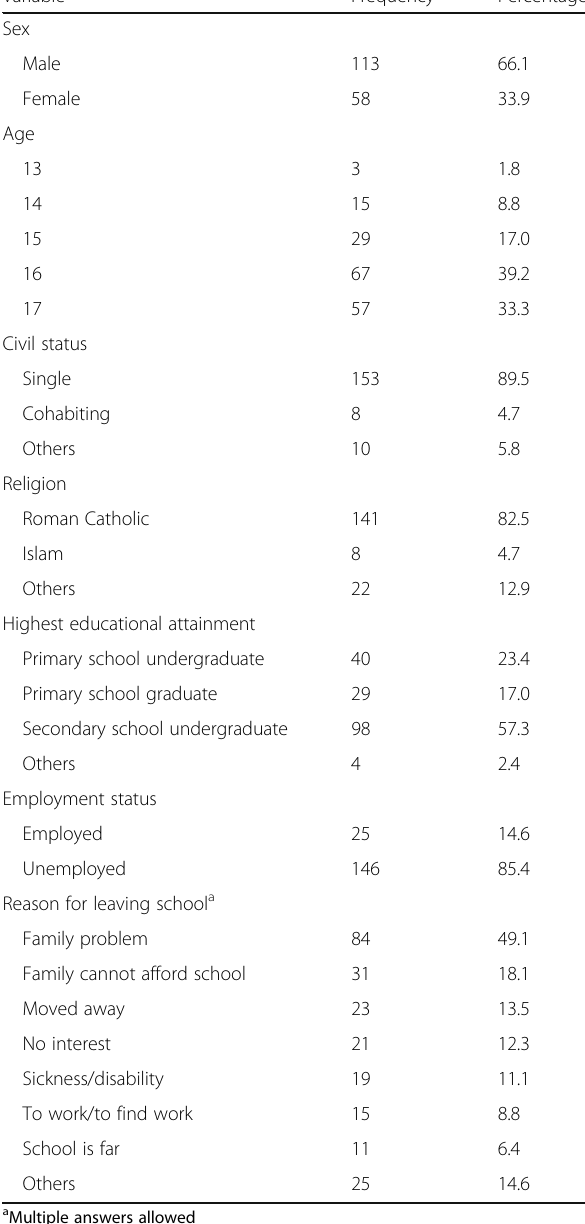
Table 1 Sociodemographic characteristics of surveyed ALS learners from 24 selected ALS centers in the city of Manila,